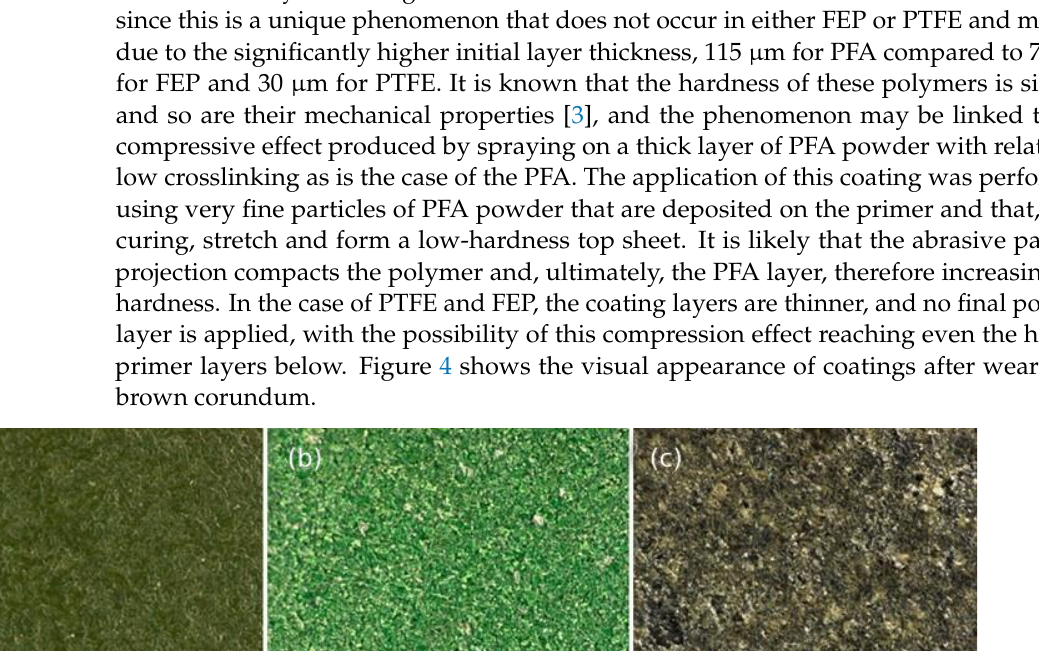
Figure 5. 3D captures (x20 confocal lens, Leica DCM8 high-definition microscope) of the coatings after projection during 4 s with brown corundum at 0.4 MPa: ( a ) PFA, ( b ) FEP, and ( c ) PTFE. In summary, the FEP and PTFE-based coatings suffered notable decreases in thick- ness, producing a decrease in hardness and worsening water repellency more intensely mainly due to the lifting and shedding of the coating. In conclusion, their use may be rarely or very rarely recommended when the wear of the surface shows an abrasive origin mainly caused by impact and shearing, which is what is generated by the brown corun- dum particles. On the other hand, it is of interest to determine the rate of loss of properties that are reached in the different fluoropolymers. The wear tests were carried out from 4 to 8 and 12 s. To do this, the scratch resistance was analyzed as one of the properties most closely related to the integrity of coatings. Figure 6 shows the variation of this response. Figure 6. Scratch resistance (N) of the coatings based on PFA, PTFE, and FEP, after 0, 4, 8, and 12 s subjected to the projection of brown corundum particles at 0.4 MPa.